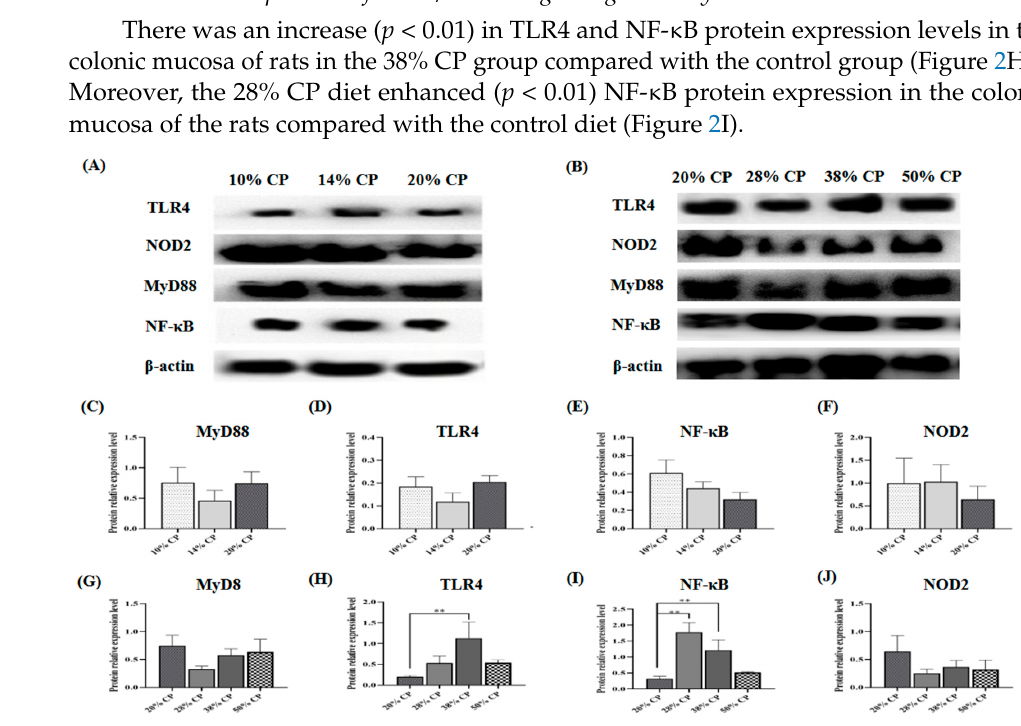
Figure 2. Effects of feeding diets with different protein contents for 6 weeks on SD rats on the TLR4/NF- κ B signaling pathway-related protein expression. Low-protein diets ( A ), High-protein diets ( B ), Myd88 ( C , G ), TLR4 ( D , H ), NF- κ B ( E , I ), NOD2 ( F , J ) in the colonic mucosal of SD rats ( n = 4). ** p < 0.01, compared with the 20% crude protein diet. There was an increase ( p < 0.05) in white blood cell and lymphocyte counts in the 14% CP group compared with the control group. Moreover, the eosinophil ratio was signi fi - cantly lower ( p < 0.05) in the 10% CP group compared with the control group. However, there were no signi fi cant di ff erences ( p < 0.05) in neutrophil, basophil, monocyte, and eo- sinophil counts and the percentages of neutrophils, basophil, lymphocyte, and monocyte among the six groups (Table 4). Table 4. E ff ects of dietary protein contents on the peripheral blood cell counts of SD rats. Parameters